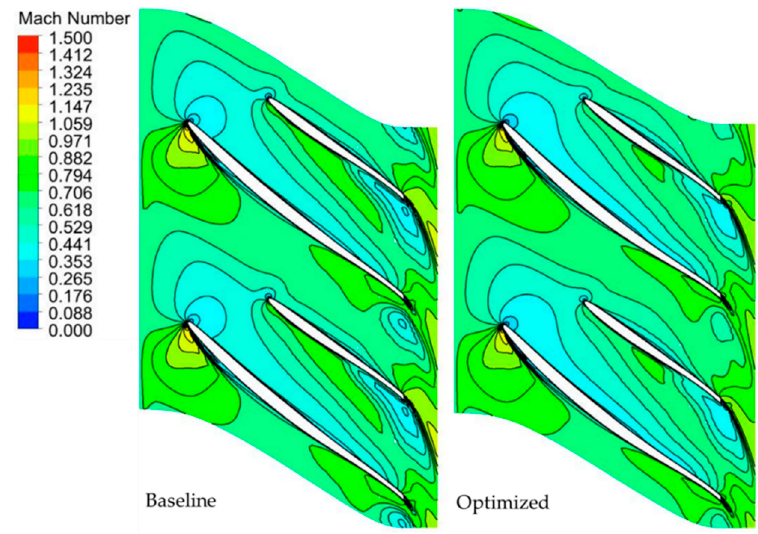
Figure 16. Mach number distribution for span 0.5 at the blade-to-blade contour.